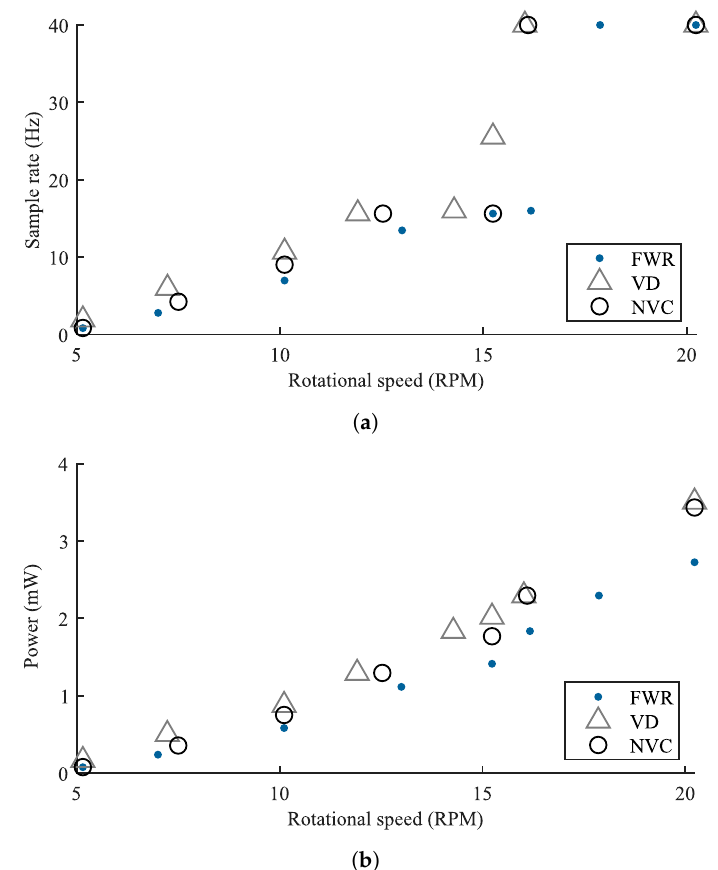
Figure 15. Sample rate ( a ) and power consumption ( b ) of the wireless RPM sensor operated at different rotational speeds, and supplied through the interface circuits with the three